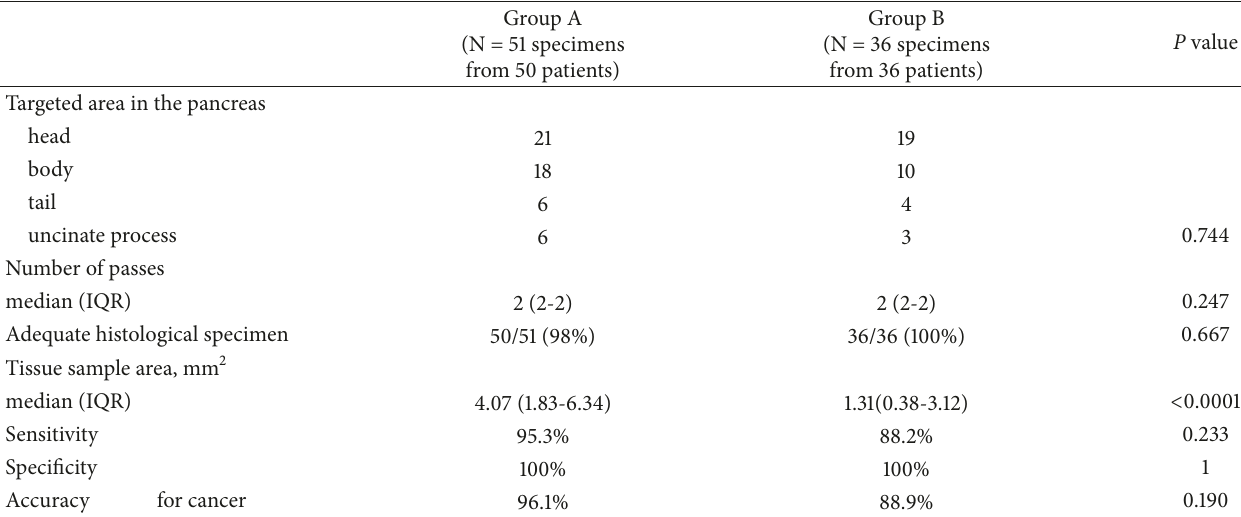
Table 2: Comparison of the specimens obtained by two needles.